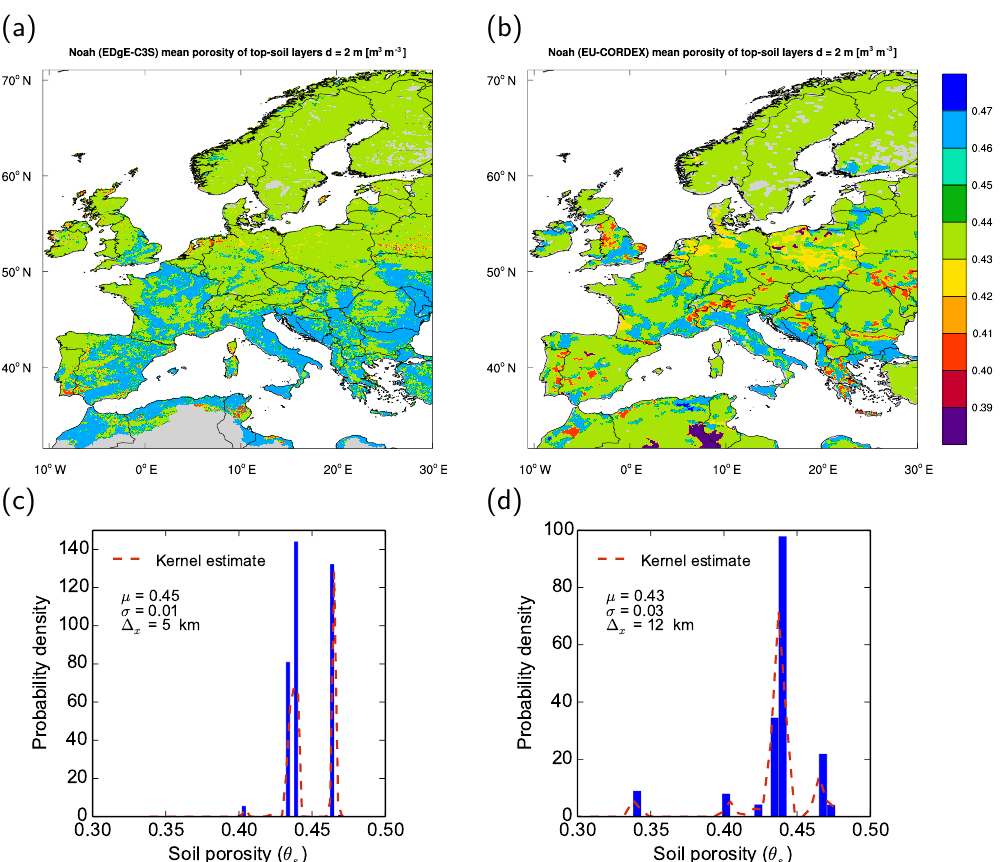
Figure 5. Porosity fields obtained using the majority upscale operator for spatial resolutions of (a) 5km and (b) 12km with the Noah-MP model used in the EDgE and EURO-CORDEX projects, respectively. Lower panels (c) – (d) show the empirical distribution function of porosity at the respective resolution and